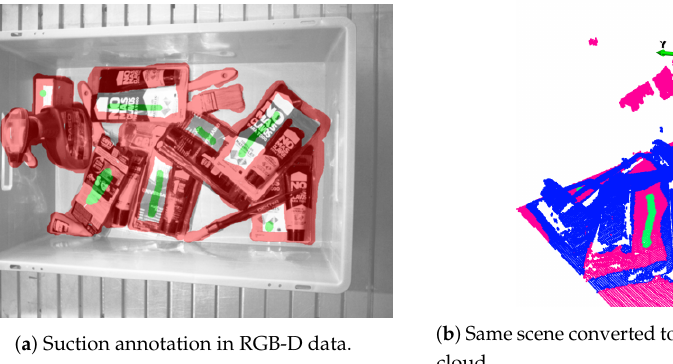
Figure 6. Annotation transformation for the suction.